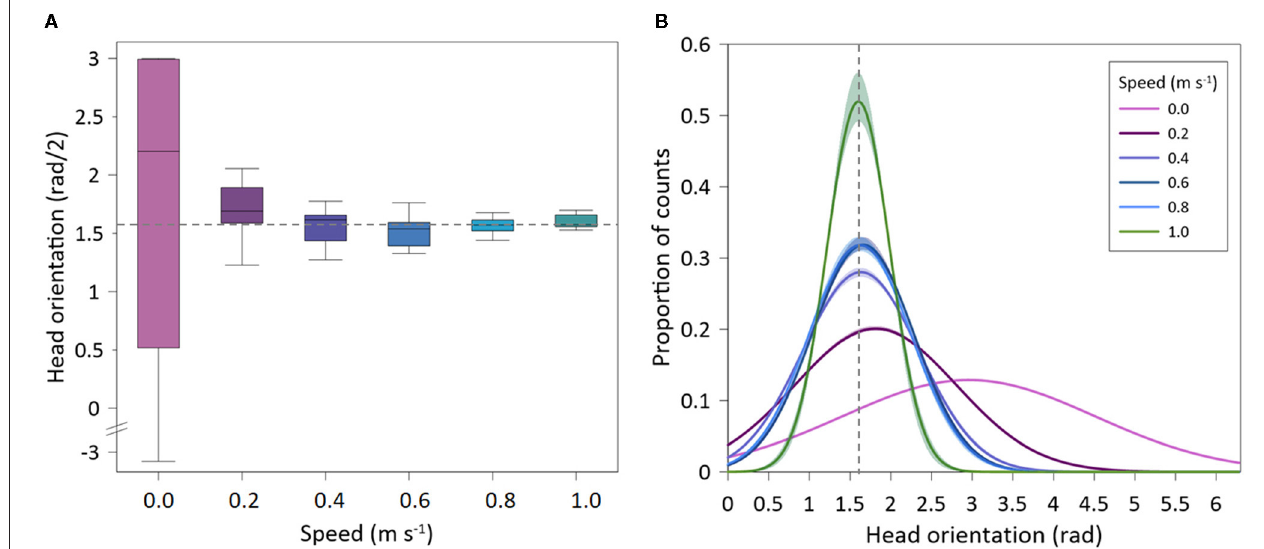
FIGURE 5 | Head orientation of Sparus aurata in swim-tunnels at different swimming speeds. (A) Box-plot of mean values; (B) Gaussian lines fitted on proportional data distribution. Dotted line: HO = 1.57rad (straight upstream swimming